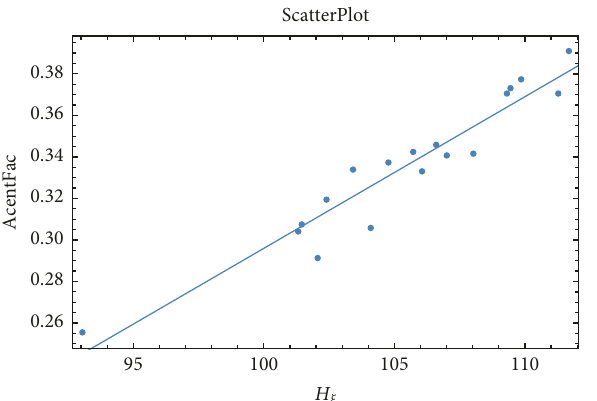
Figure 14: Plot shows the residuals for AcentFac on GA